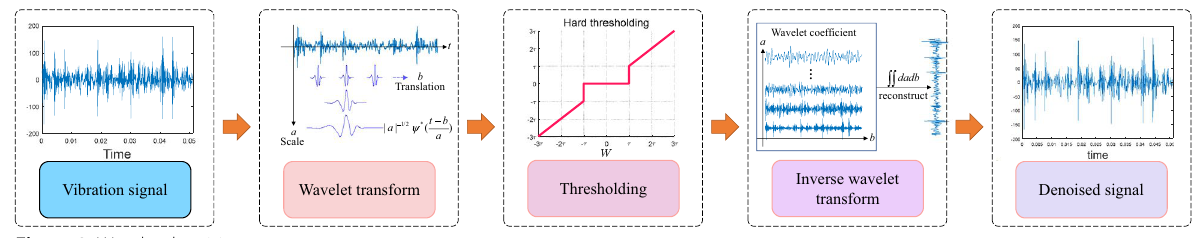
Figure 3 Wavelet